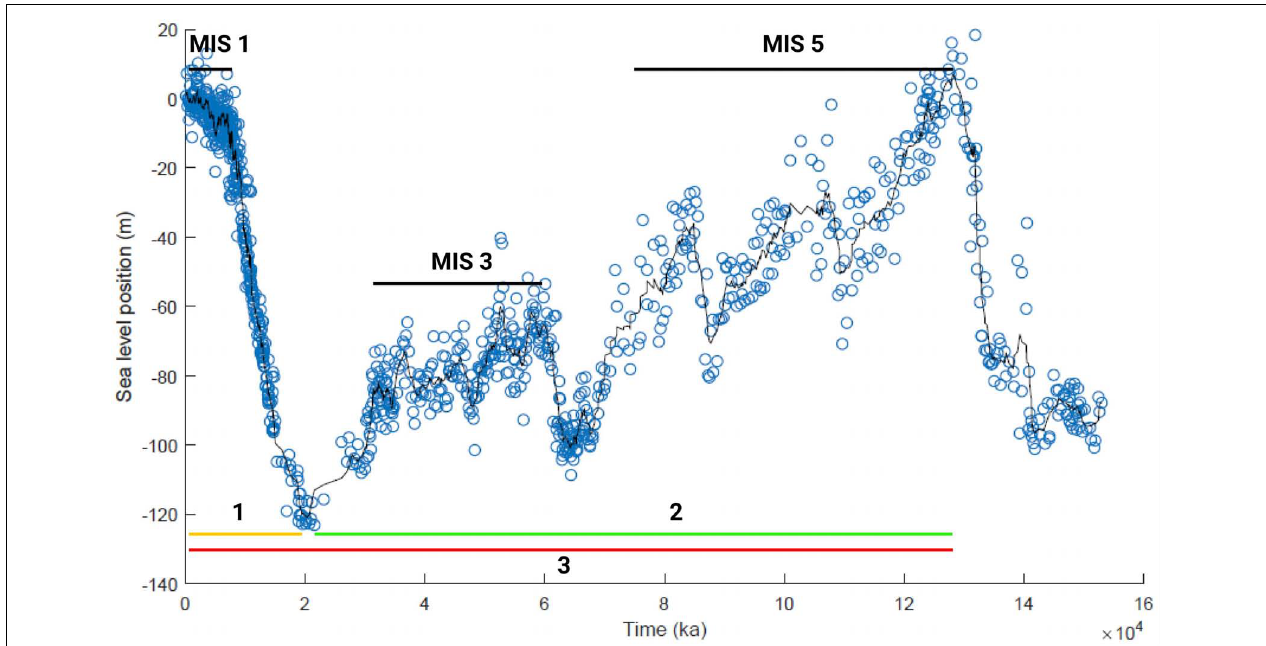
FIGURE 4 | The generated sea-level curve, and the tested three scenarios. MIS, marine isotopic stages from Railsback et al.